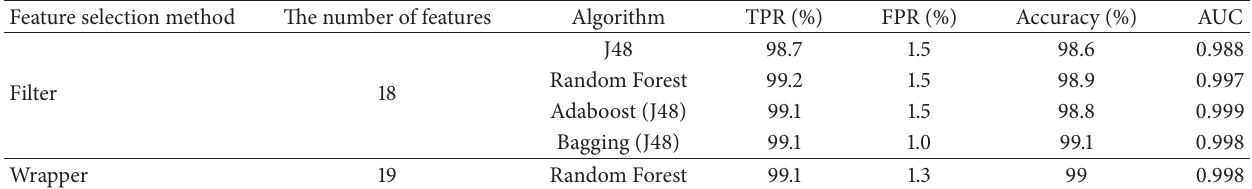
Table 5: Experimental results for all classification algorithms (feature selection only from the training set).